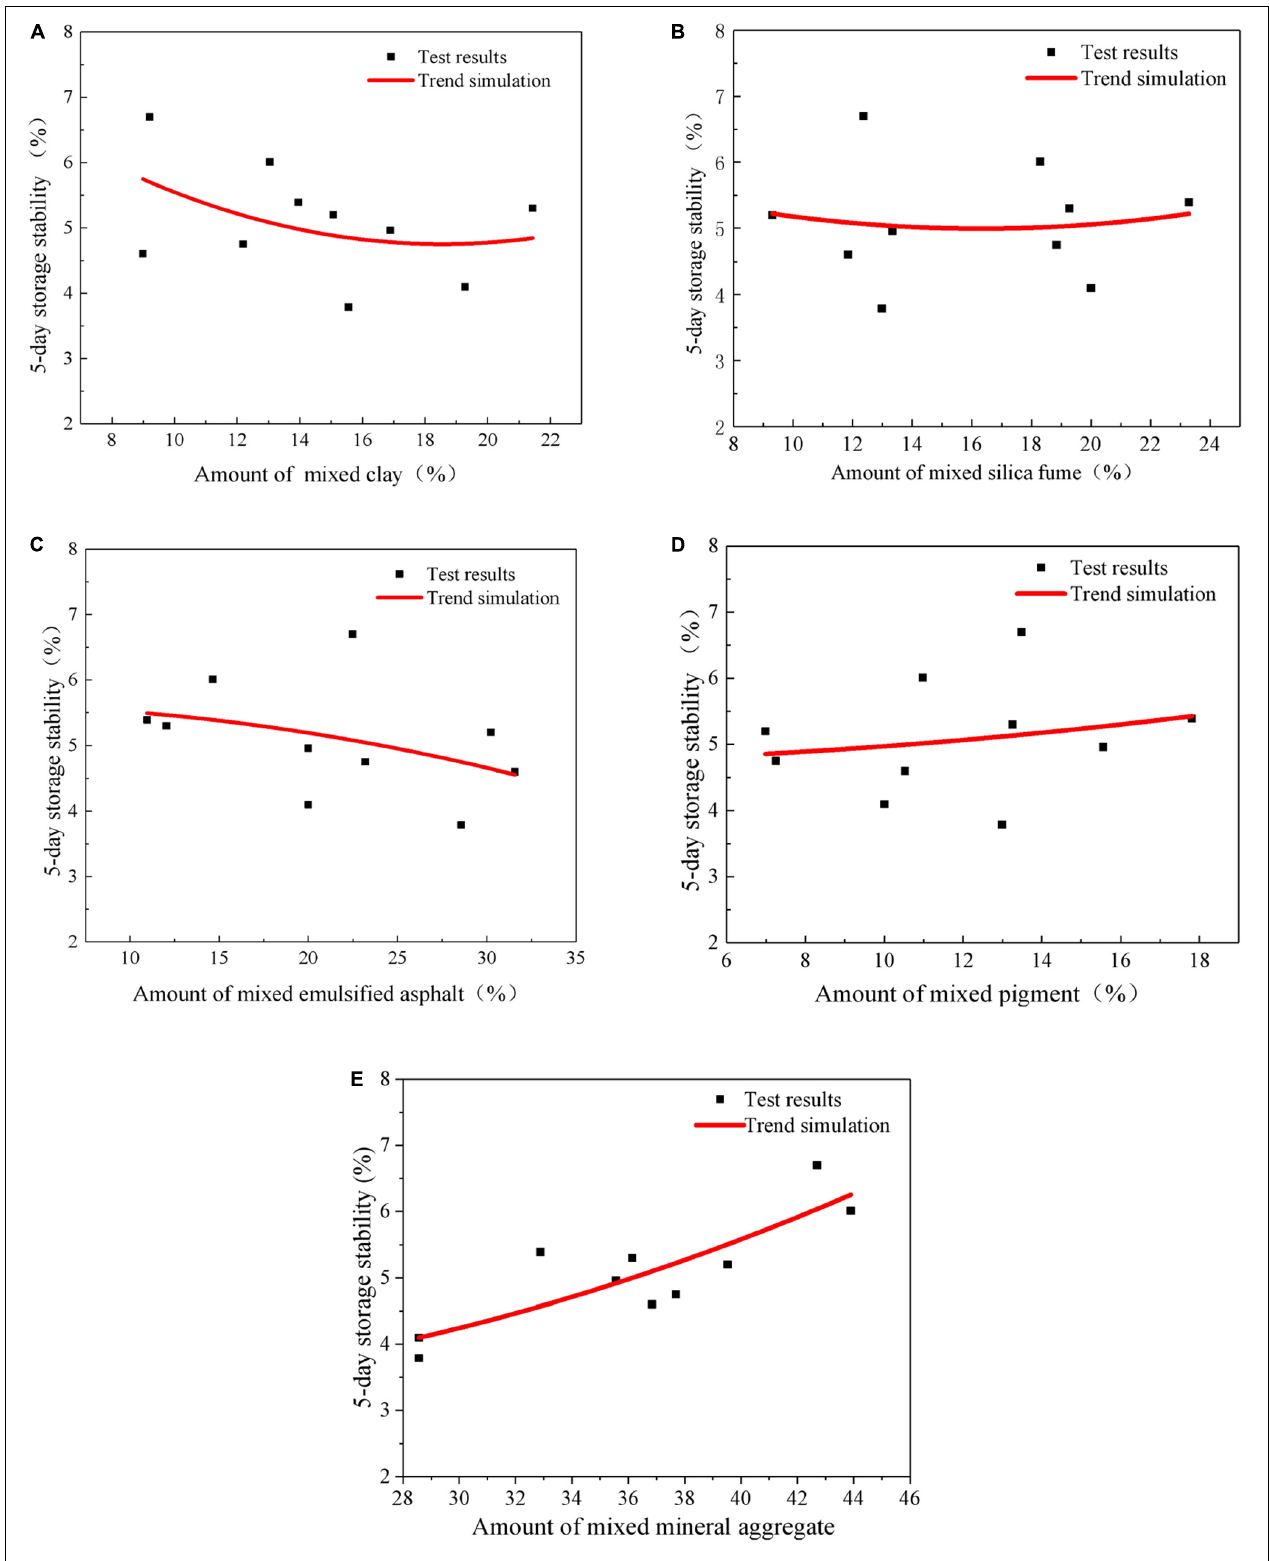
FIGURE 1 | Effect of different test factors on the 5-day storage stability of the mixtures. (A) Amount of mixed clay. (B) Amount of mixed silica fume. (C) Amount of mixed emulsified asphalt. (D) Amount of mixed pigment. (E) Amount of mixed mineral aggregate.